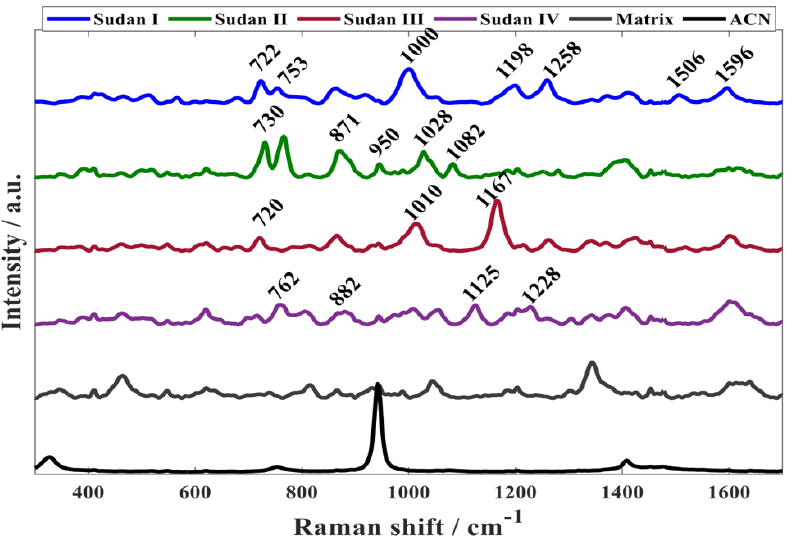
Figure 1. Representative SERS spectra of Sudan I (0.048 mM), II (0.036 mM), III (0.028 mM), and V (0.026 mM), Matrix (this is the aggregated gold nanoparticles with no dyes present so shows the citrate background) and the acetonitrile solvent (ACN).